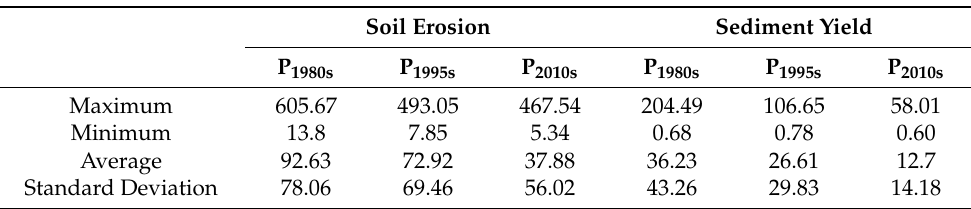
Figure 4. Sediment yield distribution of each sub-basin for the years 1980s, 1995s, and 2010s (t/ha/yr). Table 4. Statistical analysis of the soil erosion and sediment yield for the upper Ganjiang Basin for the years 1980s, 1995s, and 2010s (t/ha/yr).